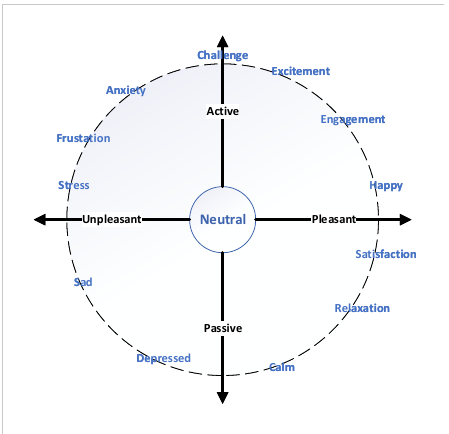
Figure 3. Arousal-Valence Space as described by Russel et al.